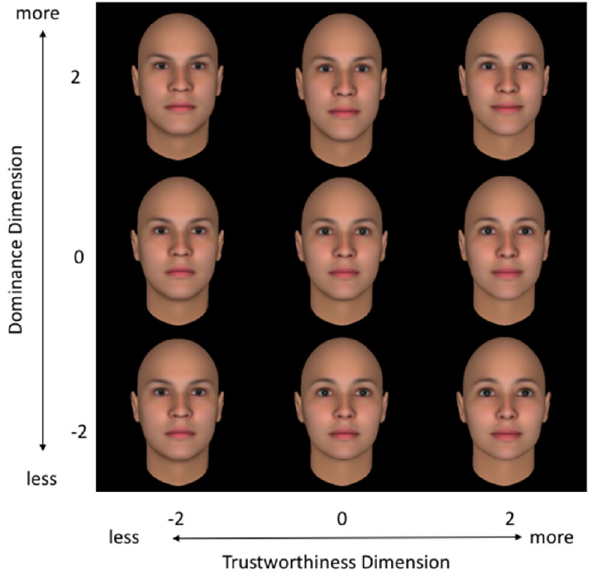
Figure 1. Stimuli in the leader choice task. The faces varied along two dimensions: Trustworthiness (X-axis) and Dominance (Y-axis), in a range of − 2 to + 2 points with an increment of 2